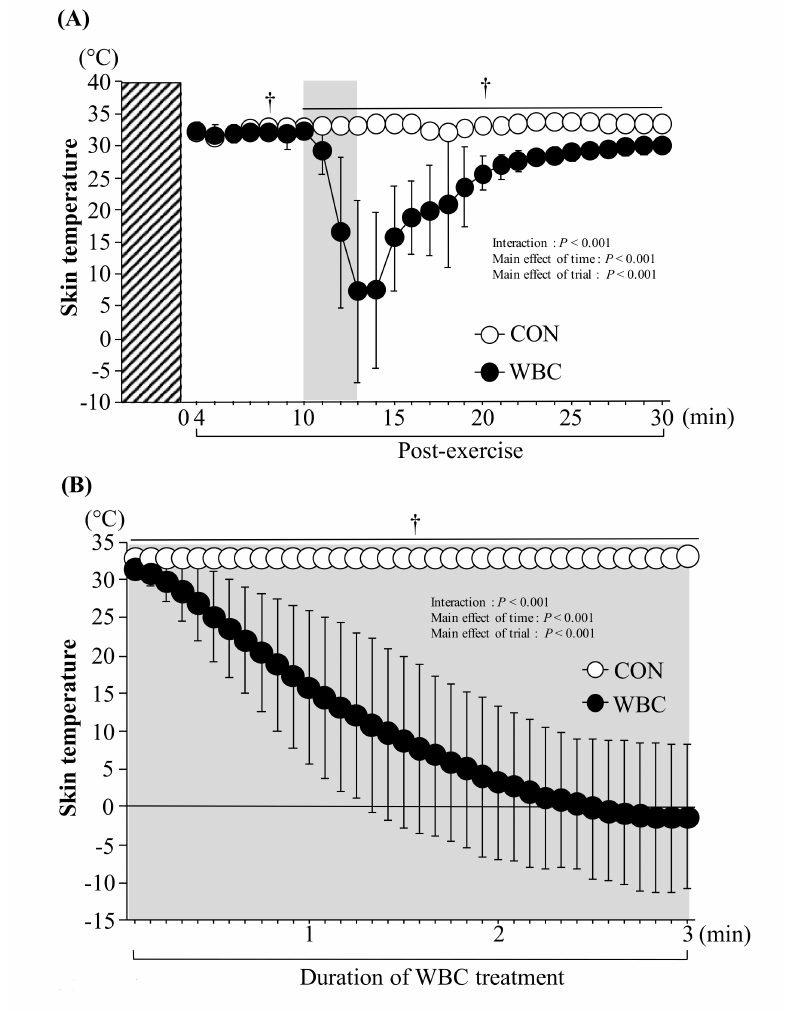
Figure 1. Skin temperature during post-exercise period ( A ) and during the WBC period ( B ). Values are means ± standard deviation (SD) ( n = 12). †: p < 0.05 vs. CON. Gray bar shows duration (3 min) of WBC treatment. A diagonal box indicates duration of exercise. WBC: whole-body cryotherapy; CON: rest